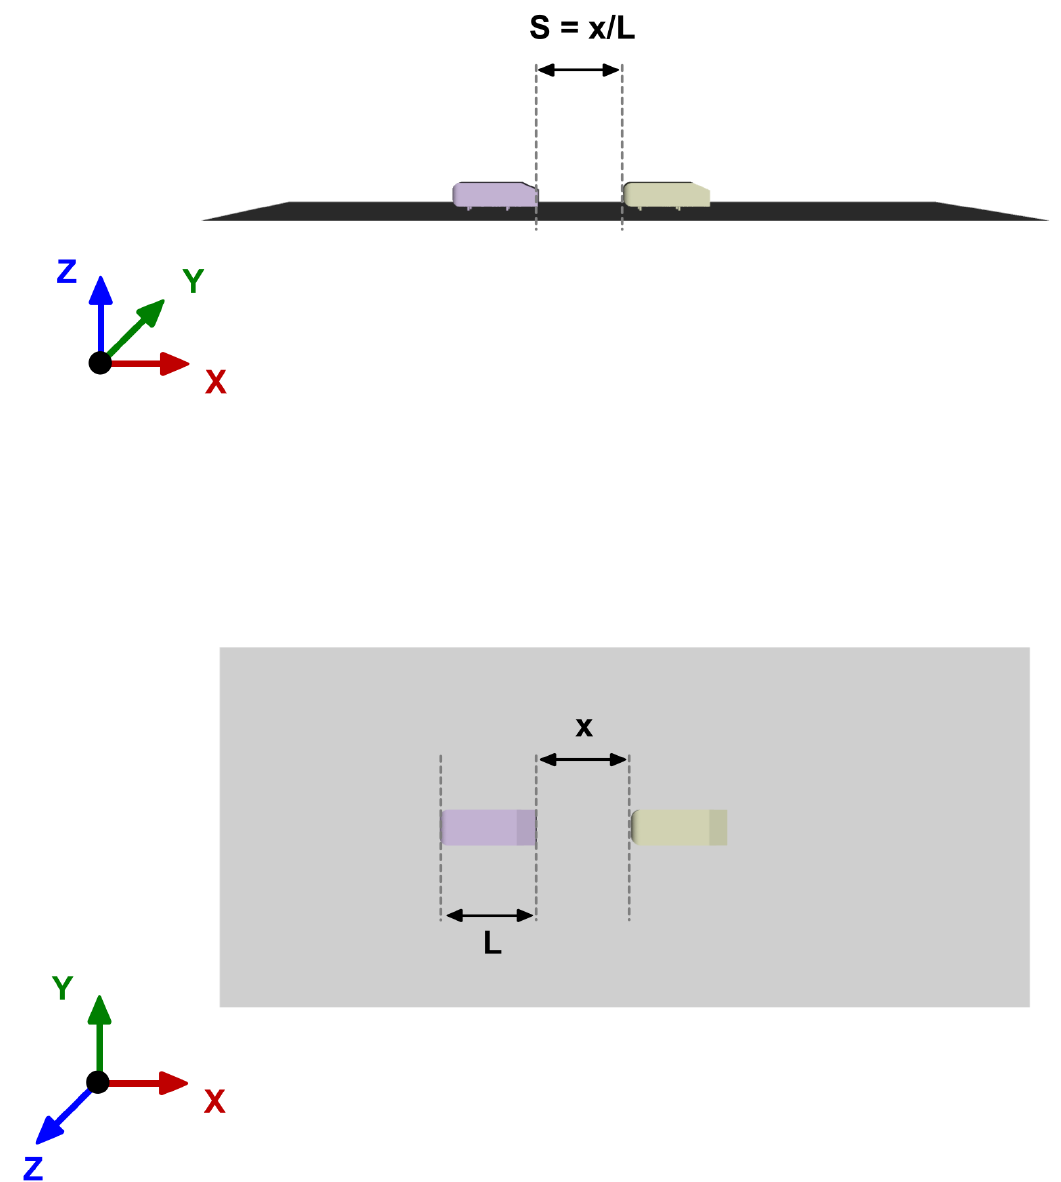
Figure 14. Spacing definition of the two Ahmed bodies, where x is the distance between the two bodies, L is the Ahmed body length, and S is the non-dimensional inter-vehicle spacing ( S = x / L